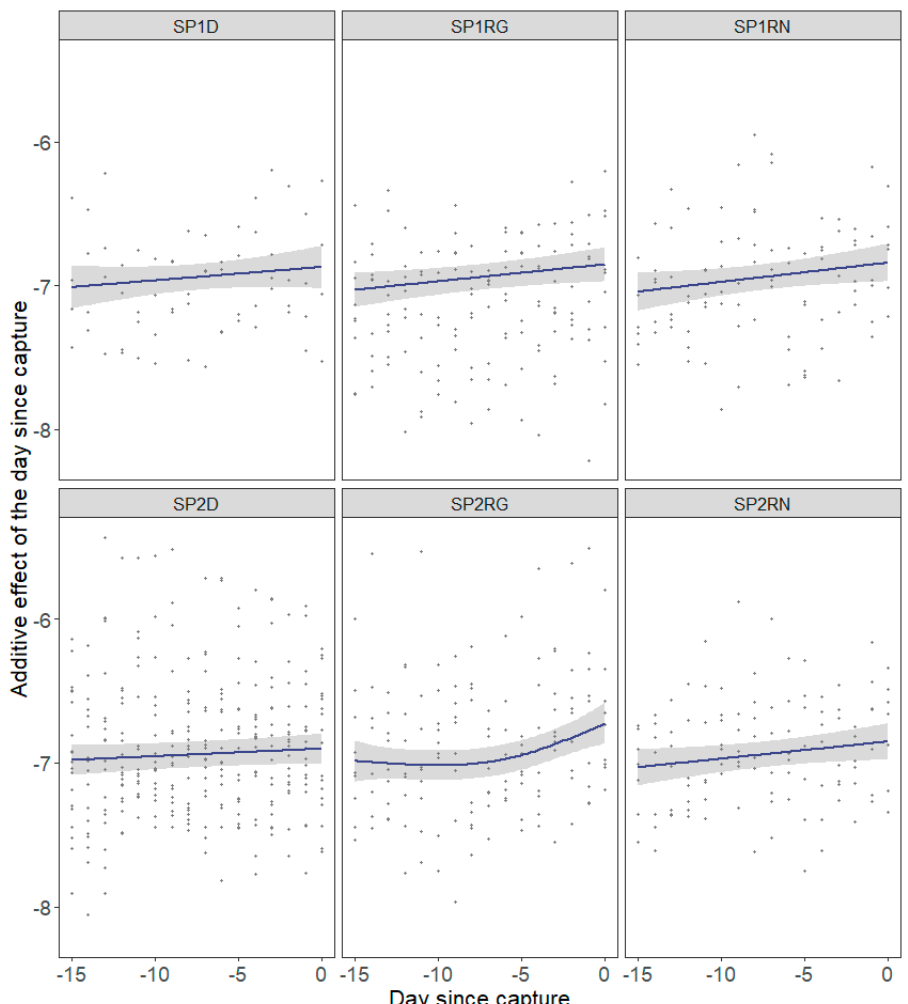
Figure 5. Response plots on the partial effects on the generalized additive mixed model (GAMM) of daily increments in the last 15 days before capture in European hake females captured in 2017. Plot includes the additive effect spawning peaks (SP1, SP2) and ovarian development phase (D, RG, RN). Solid lines denote smoothed values and shaded areas represent 95% confidence intervals.